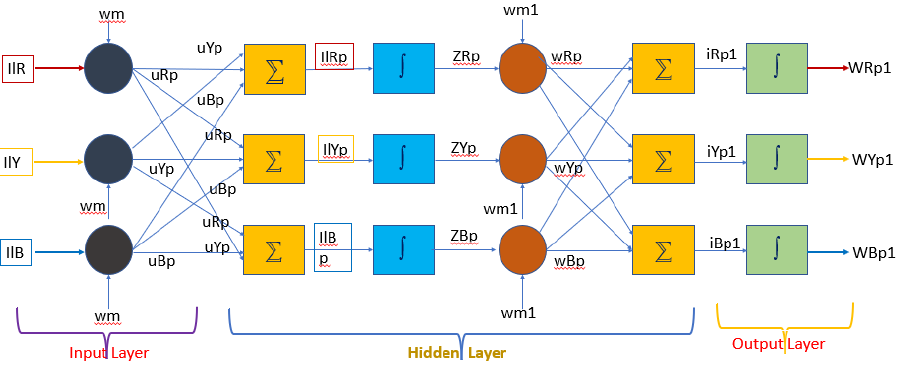
Figure 7. Configuration of the Proposed ANN based Back-propagation algorithm for VSI.